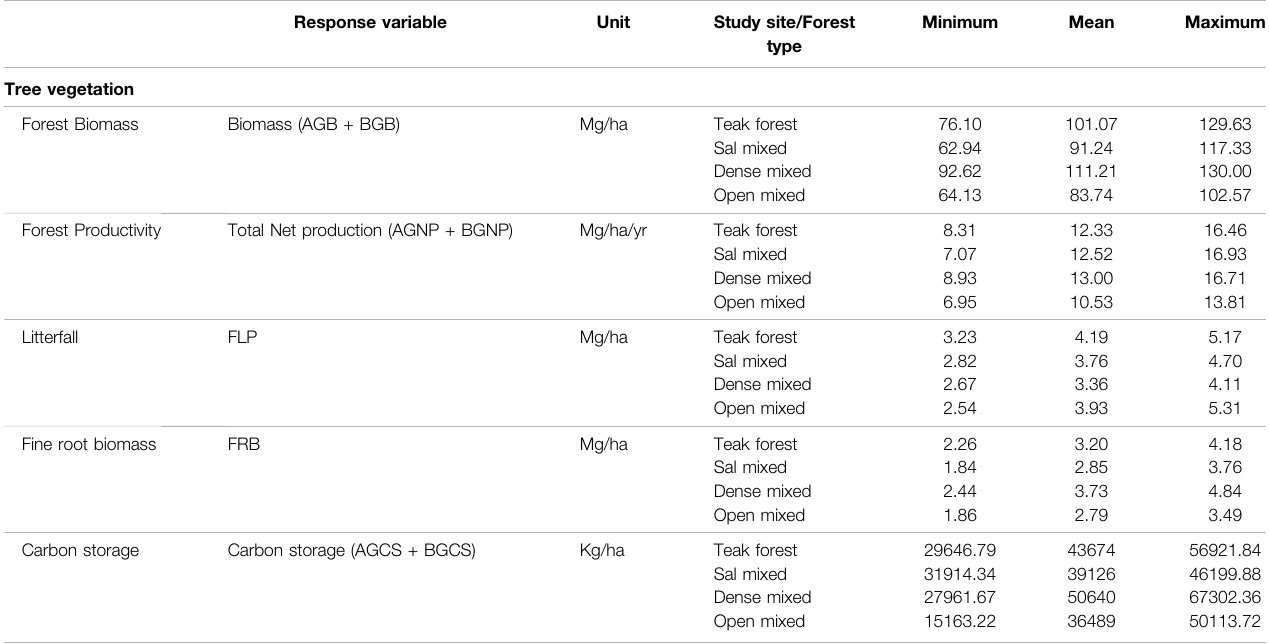
TABLE 4 | Consolidated statistics of forest biomass, productivity variables, and carbon